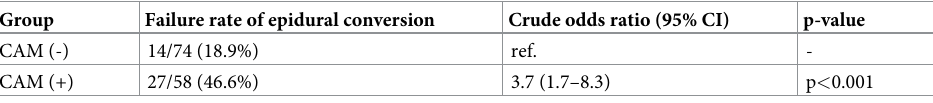
Table 3. Primary outcome; failure rate of epidural conversion. Group Failure rate of epidural conversion Crude odds ratio (95% CI) p-value CAM (-) 14/74 (18.9%) ref. - CAM (+) 27/58 (46.6%) 3.7 (1.7–8.3) p <